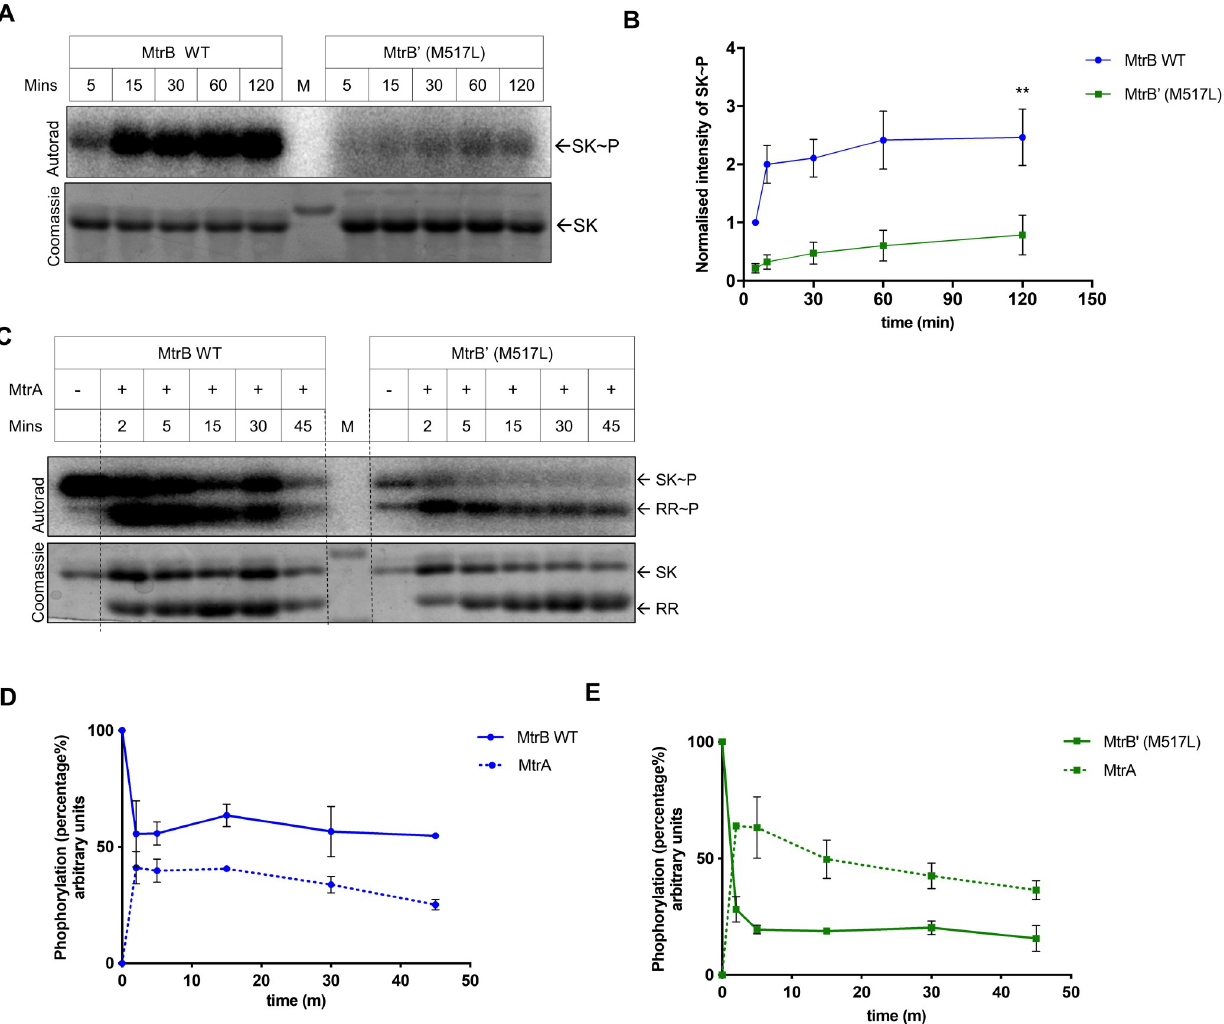
Fig 2. Assessment of the autophosphorylation and autokinase activity of the sensor kinase MtrB carrying M517L mutation. A. Autophosphorylation time-course analysis for the mutated and wild-type MtrB SK protein. M, Marker. B. Quantitative measurement of phosphorylation of the WT and mutant MtrB proteins at various time points (as shown in Fig 2A). The signal recorded for both proteins at the first time point was taken as 1 and the later time points were normalized to it (n = 3). C. Phosphotransfer time course to analyze the effect of the mutation on the phosphotransfer efficiency to the RR MtrA. The mutated or the wild-type MtrB protein were incubated with the RR MtrA (after autophosphorylation) in the phosphotransfer assay. M, marker. D and E. Quantitation of phosphorylated SK MtrB~P and RR MtrA~P protein at various time points (generated through wild type or and mutant MtrB as shown in Fig 2C). The signal recorded by the phosphotransfer of the SK at the first time point was taken as 100%, and the subsequent time points were normalized to it (n = 3) (p values; � � 0.05, �� � 0.01).